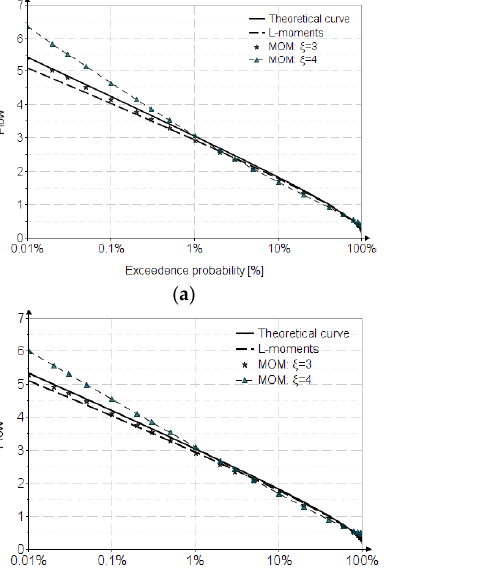
Figure 2. Theoretical and sample curves for PW and PE3. ( a ) Pseudo-Weibull, n = 20; ( b ) Pseudo- Weibull, n = 50; ( c ) Pearson III, n = 20; ( d ) Pearson III, n = 50.